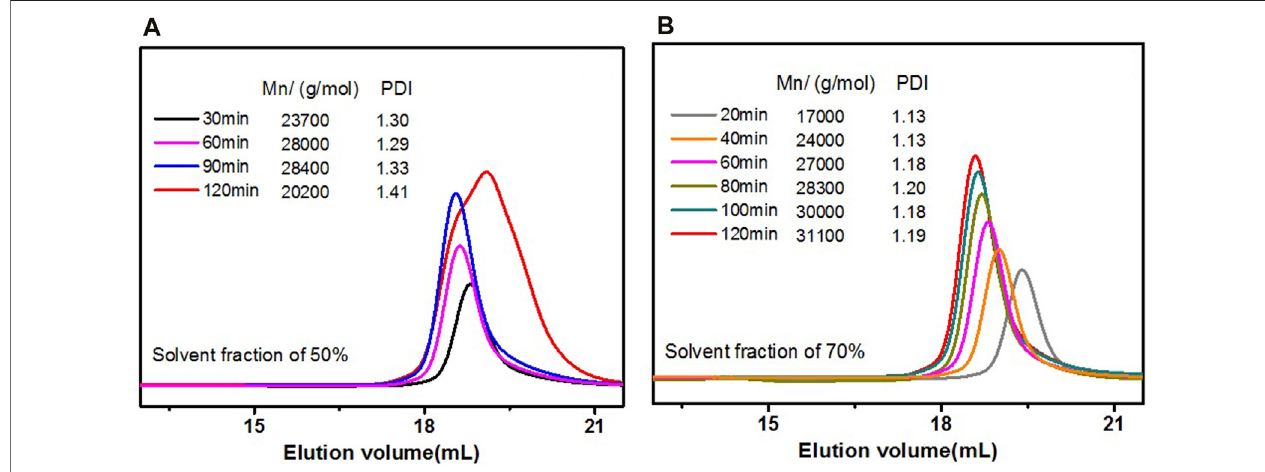
FIGURE 2 | GPC traces of DA-PLMA polymers and Mn/PDI using anisole as a solvent with different reaction times: (A) solvent fraction of 50% and (B) solvent fraction of 70%.